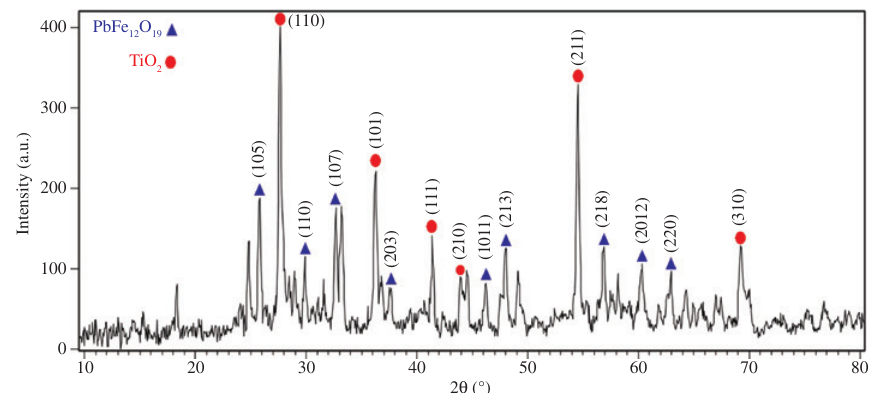
nanoparticles. 2